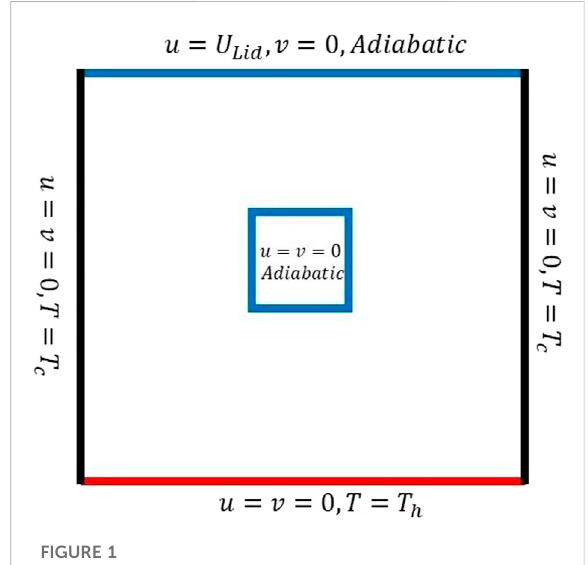
FIGURE 1 Graphical representation of a physical model.